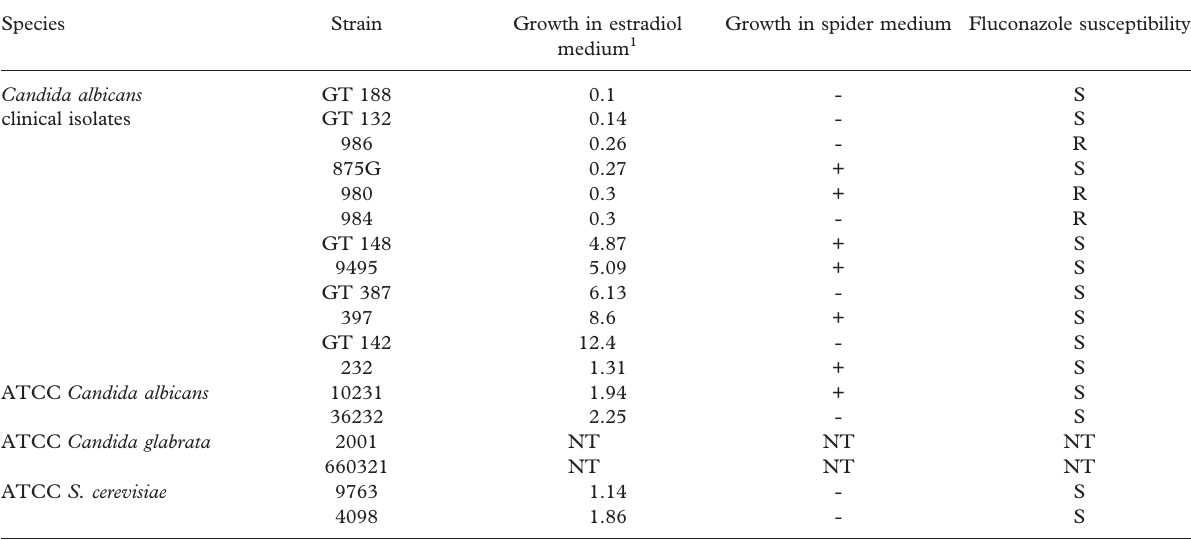
Table I. Characteristics of yeast strains used in this